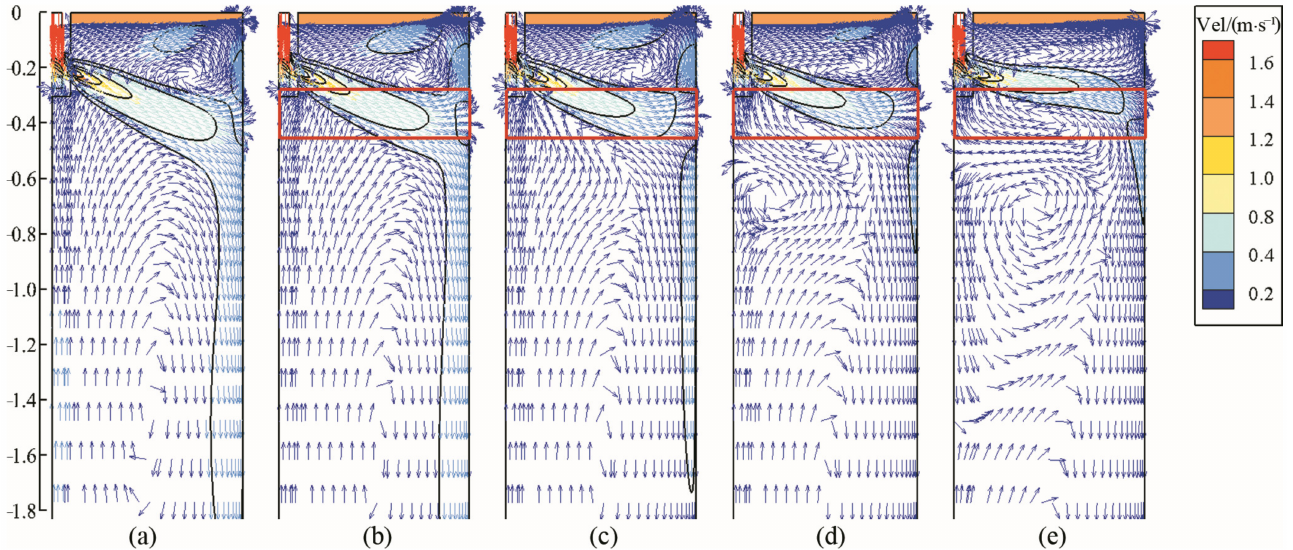
Figure 5. Distribution of the molten steel flow field in the central plane of the mold thickness with various magnetic flux densities: ( a ) B max = 0 T, ( b ) B max = 0.1 T, ( c ) B max = 0.2 T, ( d ) B max = 0.3 T and ( e ) B max = 0.5